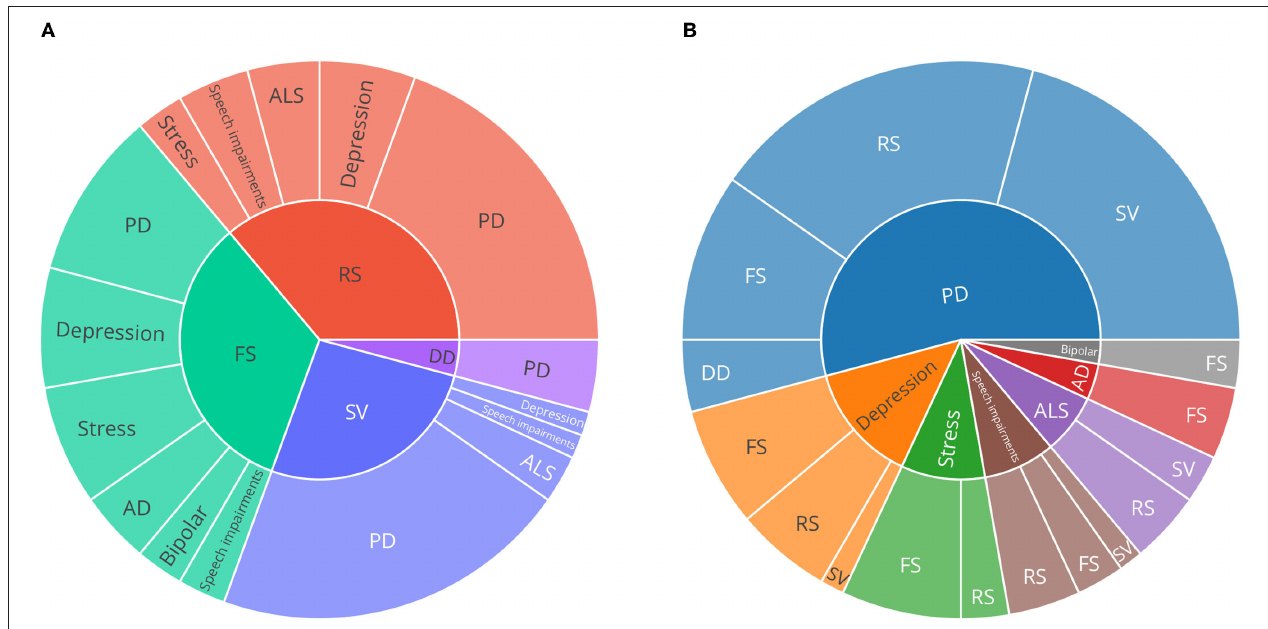
FIGURE 3 | Sunburst charts describing the proportion of speech tasks and neurological disorders. (A) speech task categories on the inner circle, (B) disorders on the inner circle. Only publications describing original (newly recorded) datasets were considered to provide an overview of emerging trends in the field. PD, Parkinson’s disease; AD, Alzheimer’s disease; ALS, amyotrophic lateral sclerosis; SV, sustained vowels; DD, diadochokinesis; RS, read speech; FS, free speech.